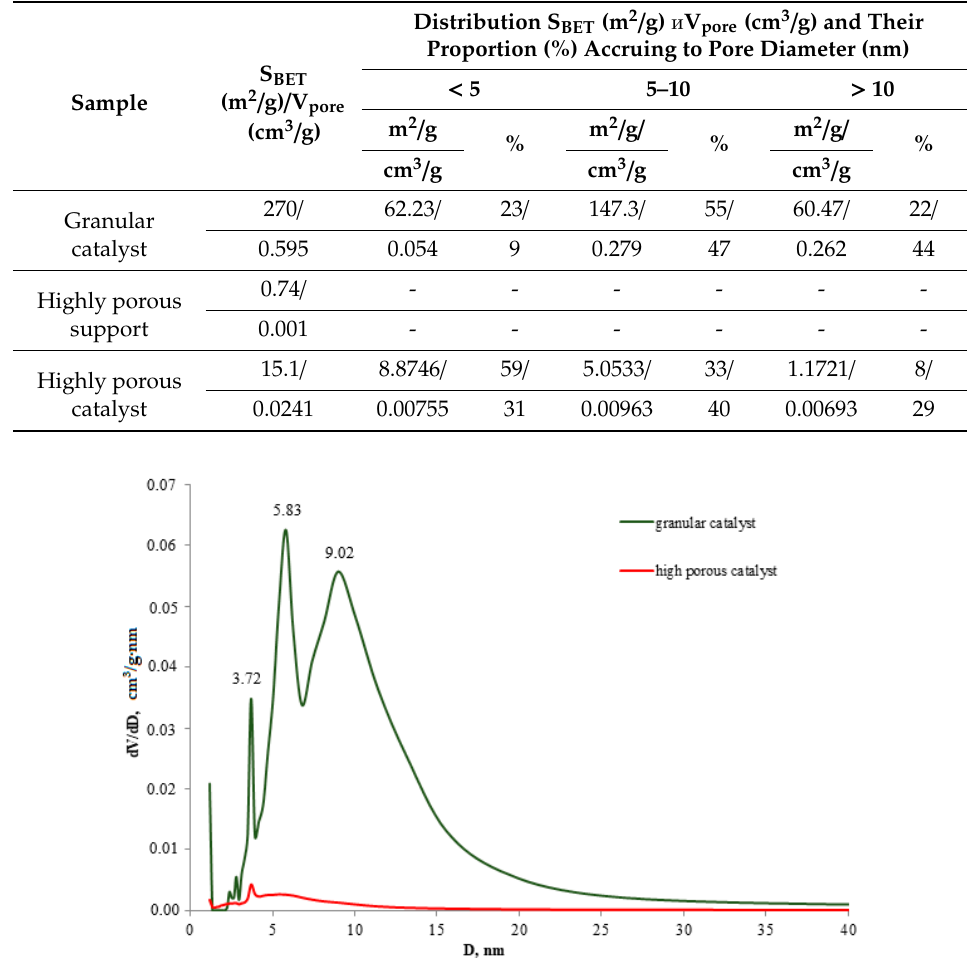
Figure 4. Differential curves of pore volume distribution. Figure 4. Di ff erential curves of pore volume